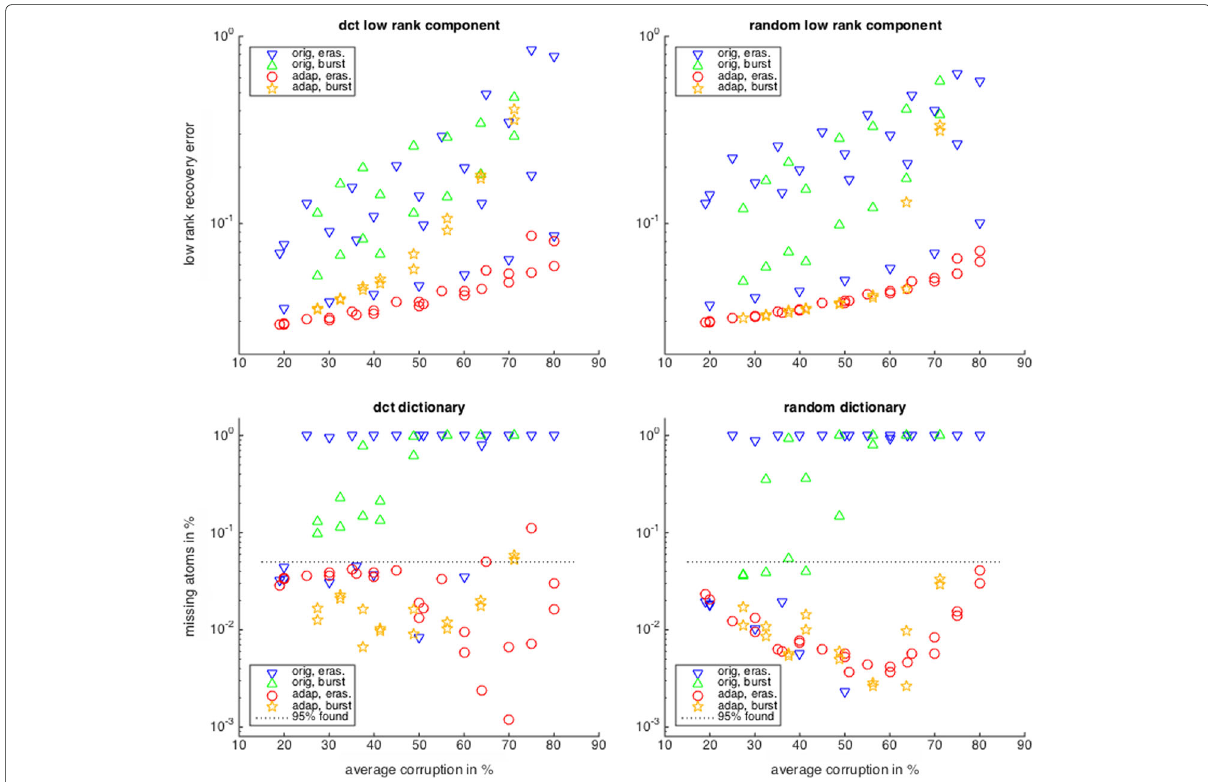
Fig. 2 Recovery performance of the corruption adapted versus the unadapted learning algorithms for the DCT (left) and the random (right) representation pair. The recovery performance is measured in terms of the low-rank recovery error (top) and the percentage of unrecovered dictionary atoms from a random initialisation